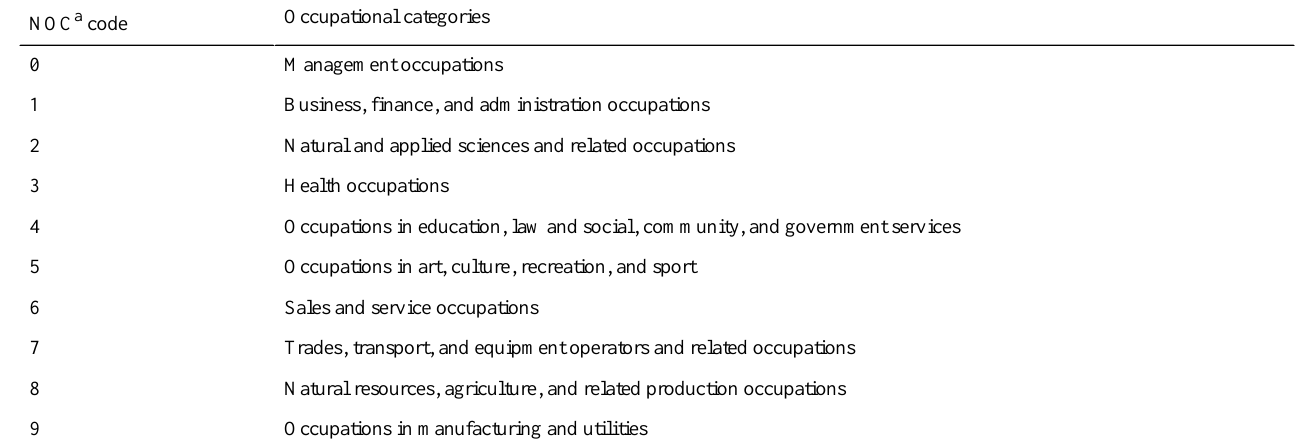
Table 1. Occupational categories of the Canadian National Occupational Classification (first